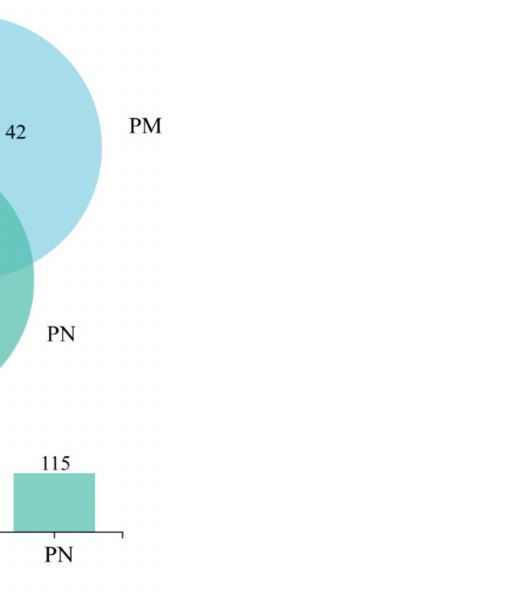
Figure 1. Venn diagram of the rhizosphere soil fungal composition of P. tabuliformis on genus level at different stand ages. PY: young forest (10a), PM: middle-aged forest (20a), and PN: near-mature forest (30a). Table 2. The rhizosphere soil fungal diversity index of P. tabuliformis at different stand ages. Sites